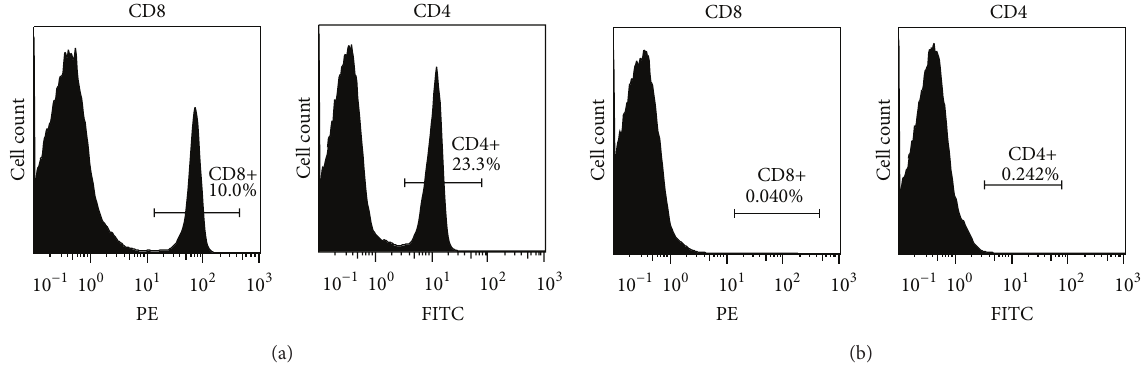
Figure 1: Flow cytometry analysis of splenocytes from animals (a) untreated and (b) treated with either rabbit polyclonal anti-CD4 or anti- CD8 antibody. Animals received two doses of depletion antibodies in three-day interval and were sacrificed two days after the second dose. The splenocytes were stained with rat monoclonal anti-CD4-FITC or anti-CD8-PE antibody.